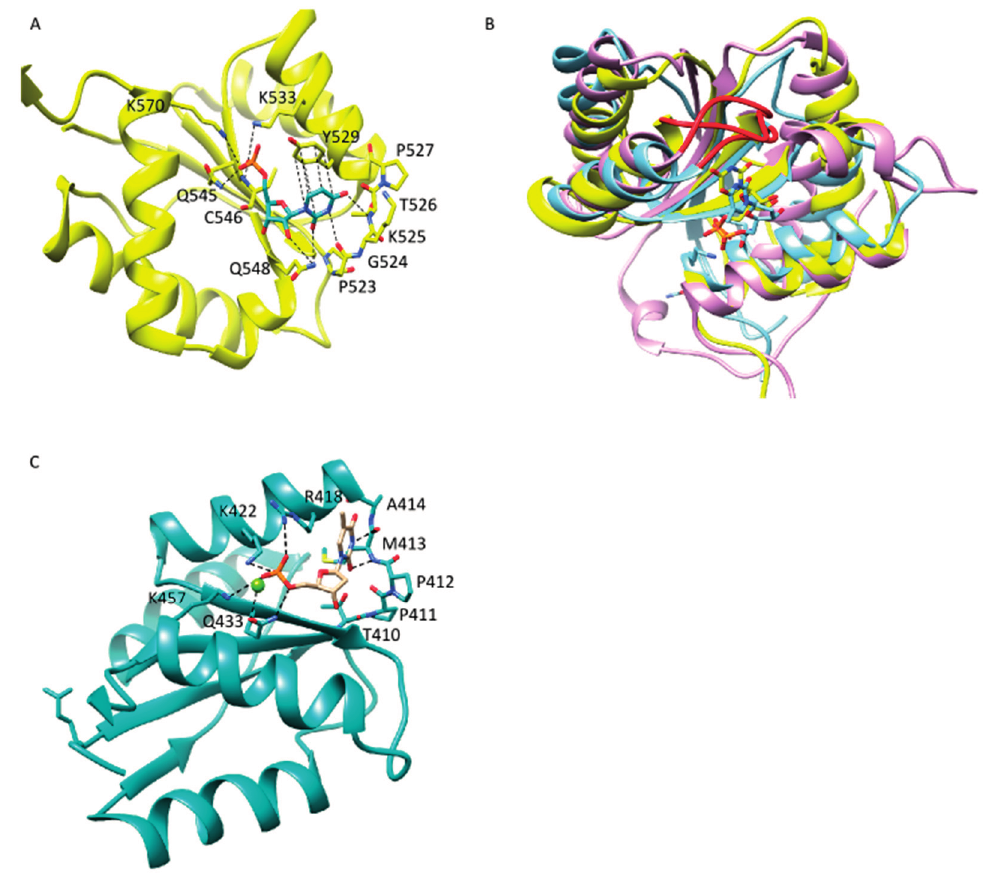
Figure 2. Binding of the guide 5 ′ -end by the Mid domain of Ago. ( A ) Mid domain of hAgo2 (pdb: 4W5N) in complex with a 5 ′ -uracil of the guide RNA. Residues interacting with the 5 ′ -phosphate and the 5 ′ -base are highlighted according to Frank et al. [42]. Backbone of the nucleotide specificity loop (NSL) is depicted in atoms/bonds representation; ( B ) Overlay of the Mid domains of hAgo2 (pdb: 4W5N) in yellow, TtAgo (pdb: 3DLH) in blue and P. furiosus Ago (PfAgo) (pdb: 1U04) in purple. The regions corresponding to the NSL are highlighted in red; ( C ) Mid domain of TtAgo in complex with a 5 ′ -thymin. Residues possibly interacting with the 5 ′ -nucleotide are highlighted according to Frank et al. [42]. Backbone of the region corresponding to the NSL is depicted in atom/bond